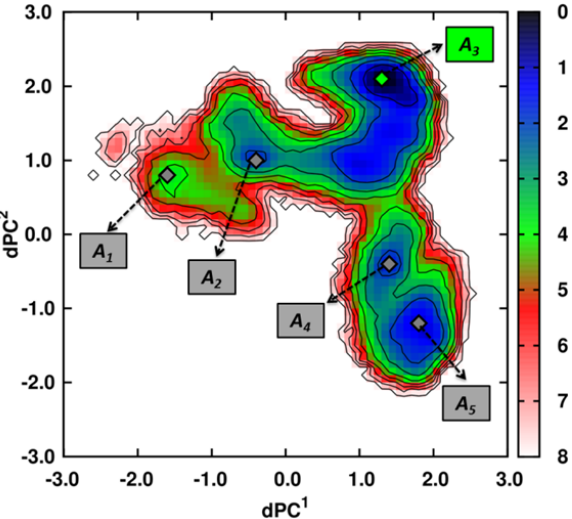
Figure 8. Dihedral principal component analysis applied to MD simulations of ATP-bound DnaK. FES computed for the MD run ATP1. Minima are shown with gray (green for the most probable one) diamonds and the isolines (black lines) are drawn every k B T unit. The color scale for the free-energy is in k B T units.